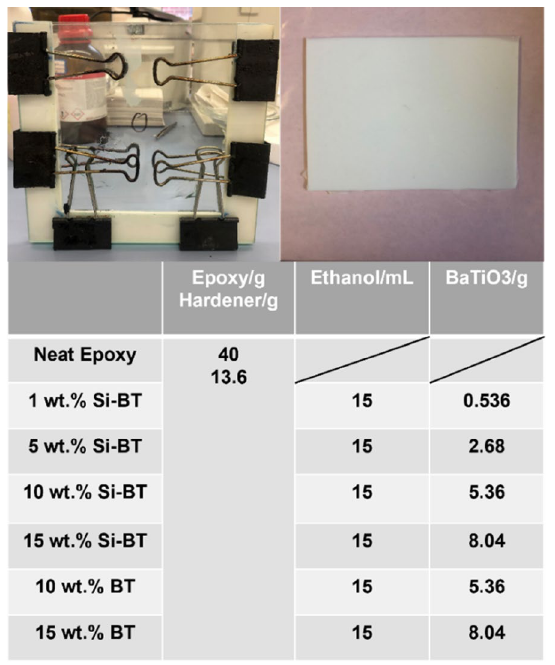
Figure 10. Glass mould used for nanocomposite fabrication and the cured nanocomposite